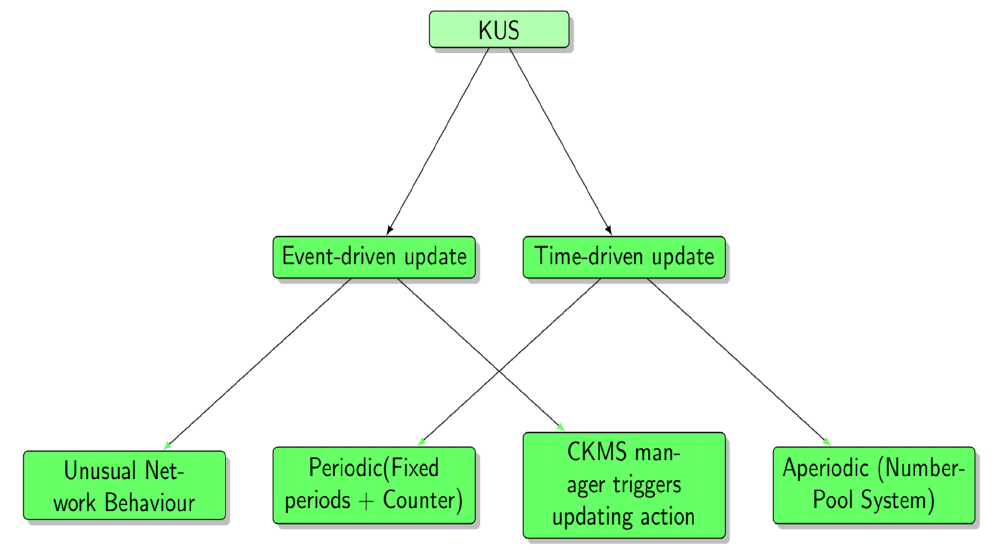
Figure 3. A tree-diagram illustrates